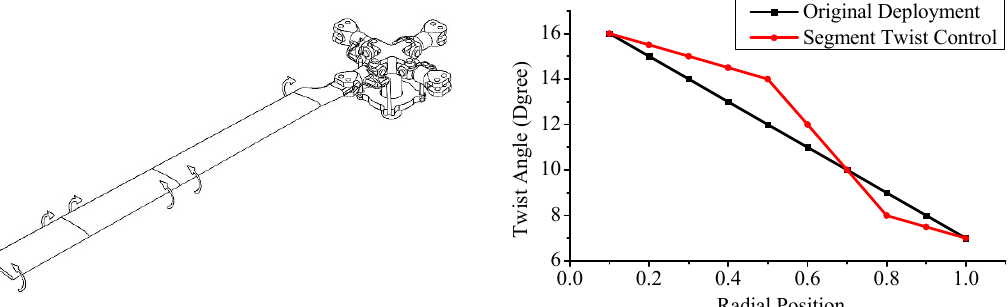
Figure 7. Schematic diagram of the segment twist control configuration.